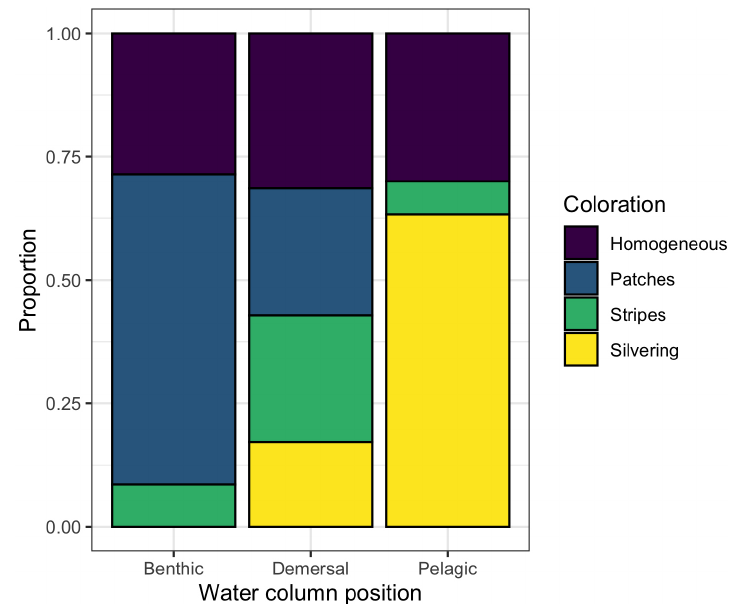
FIGURE 3 | Coloration of reef fish species by their position in the water column (benthic, n = 35; demersal, n = 35; pelagic, n = 30). Homogeneous refers to the presence of a moderately homogenous non-silvering color pattern without large contrasting patches (typical of background matching); patches refer to the presence of contrasting contour breaks patches (typical of disruptive coloration); stripes refer to the presence of highly contrasting regular stripes ( e.g ., black and white stripes, typical of motion-dazzle strategy), and silvering to fishes with silvery homogenous body coloration.